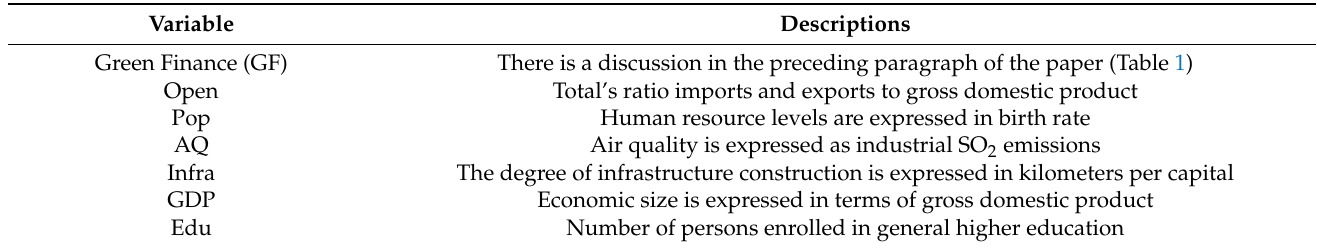
Table 2. Description of related variables and data